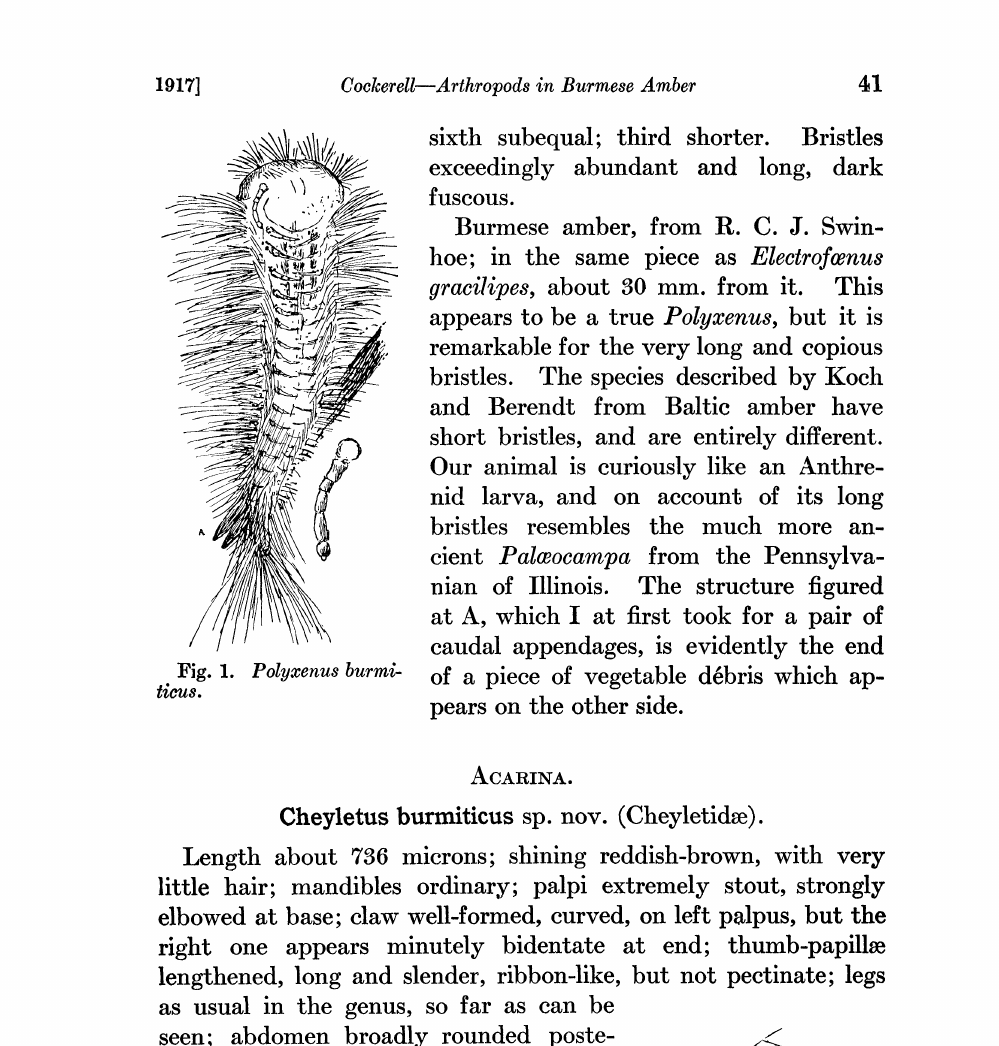
. Cheyletus burmi- Fig. titus. A, palpi; B, base of first